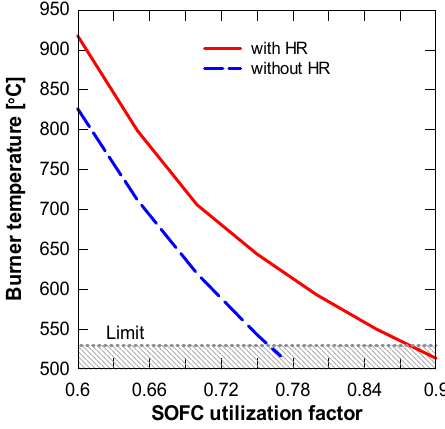
Figure 12. Burner outlet temperature as function of SOFC utilization factor.